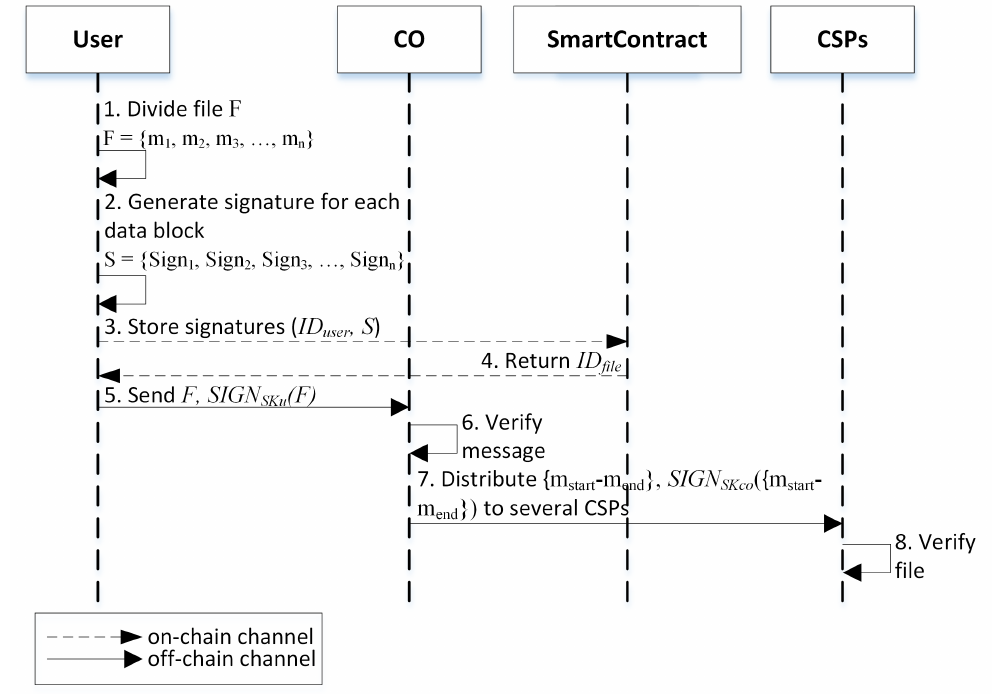
Figure 3. Data storing